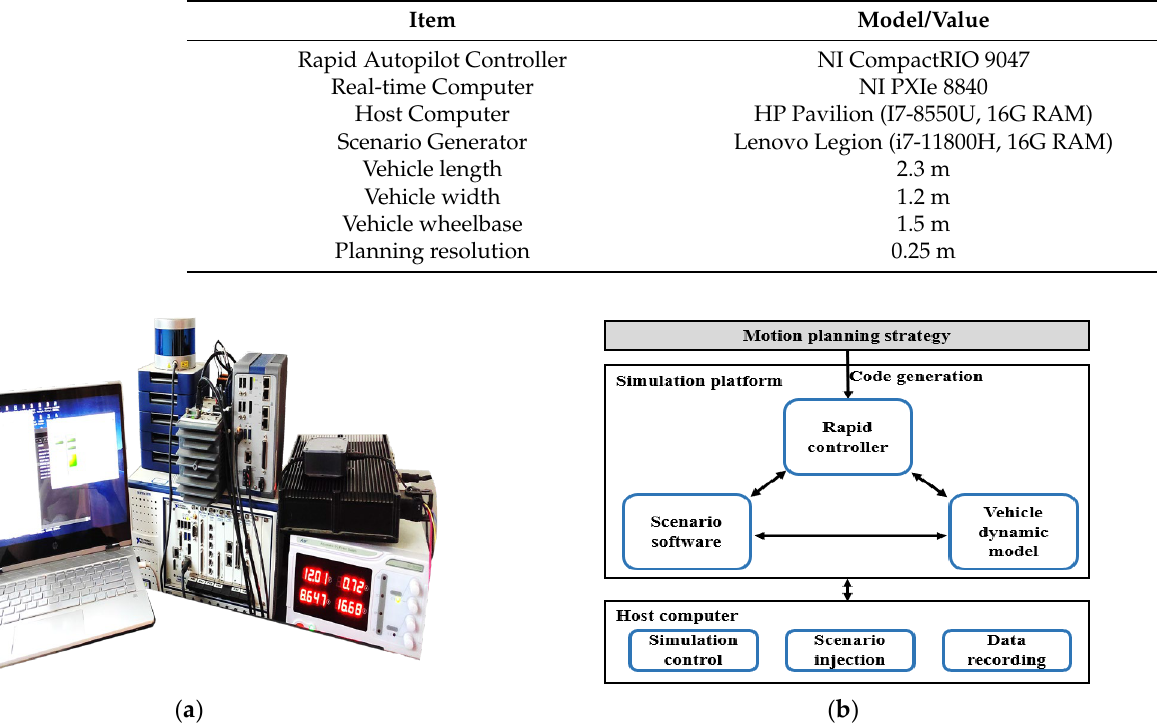
Figure 14. Hardware-in-loop simulation platform. ( a ) hardware-in-loop simulation system; ( b ) system architecture.